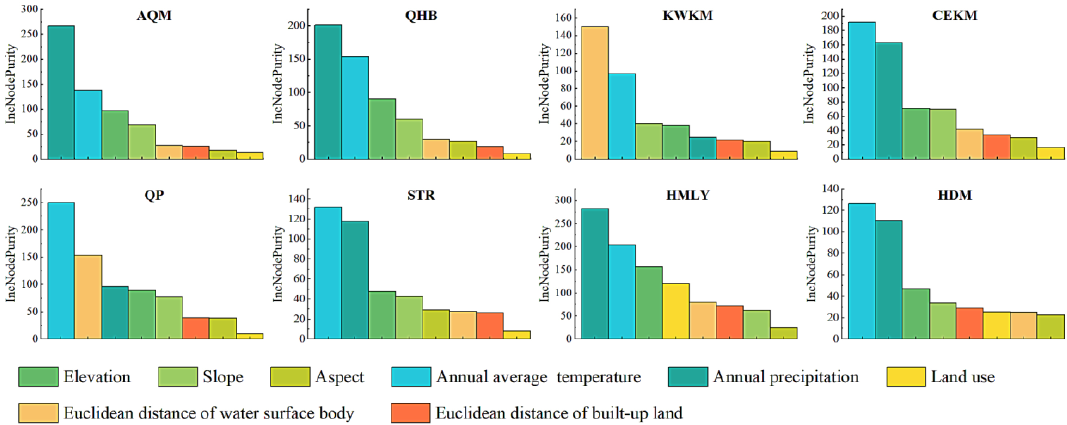
Figure 14. Ranking of the importance of factors in different geomorphological divisions of the QTP.